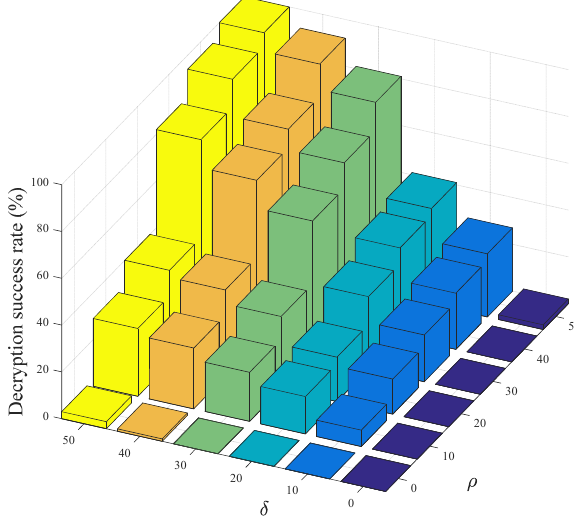
Figure 17. Decryption success-rate under various combinations of ρ and δ .